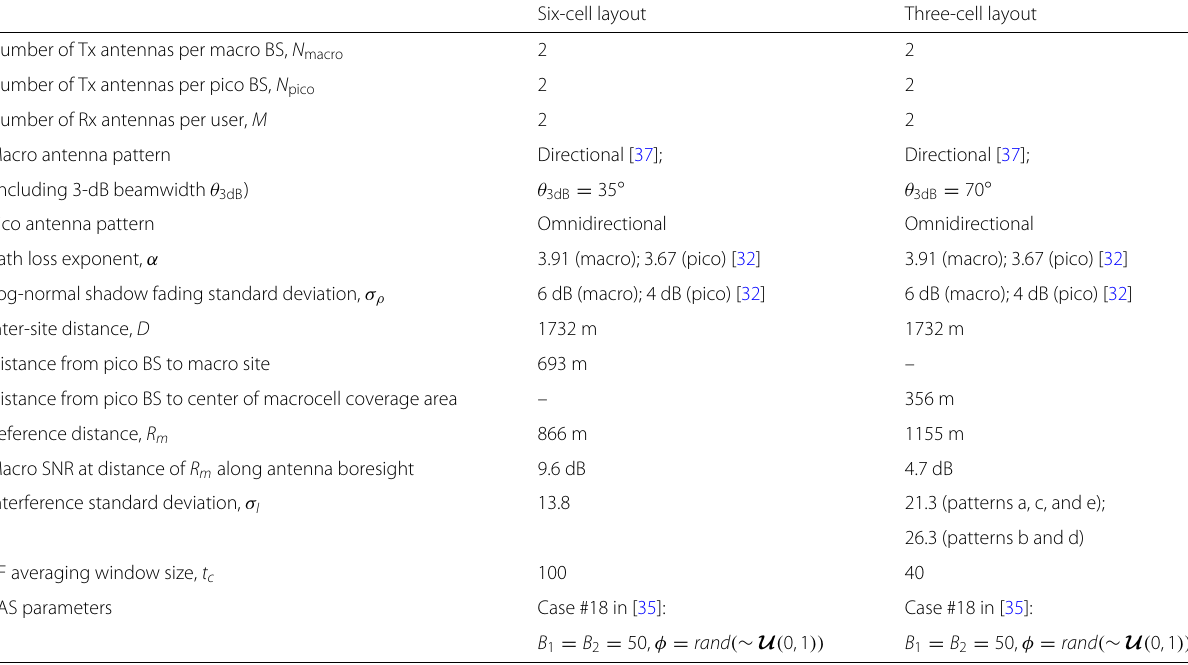
Table 1 Simulation setup parameters and values for six-cell and three-cell layouts Six-cell layout Three-cell layout